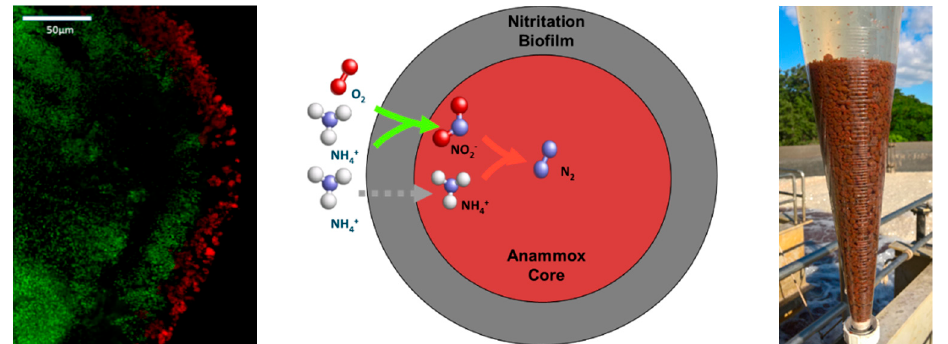
Figure 4. A FISH image of a cross-section of an ANAMMOX granule ( left ) indicating the anammox bacteria (green) and the outer-layer biofilm indicating the aerobic ammonia-oxidizing bacteria (red) and the simplified layered granular sludge model with the associated biological reactions ( middle ) and an Imhoff cone with PN/A ANAMMOX granules ( right ).